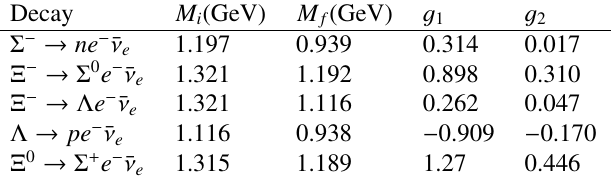
Table 2. The decay constants g 1 ( Q 2 = 0) and g 2 ( Q 2 = 0) for the strangeness changing decays.